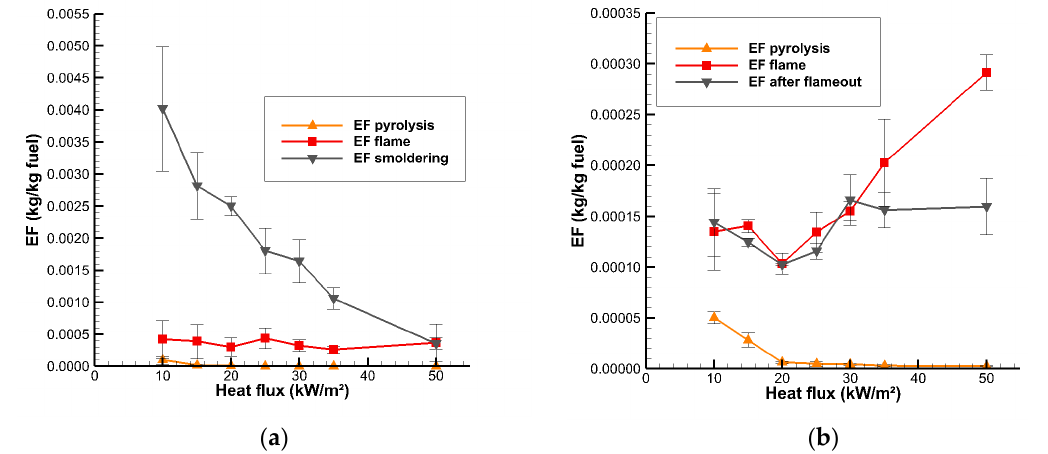
Figure 14. EF for CH 4 for an imposed heat fl ux ranging from 10 to 50 kW/m 2 for ( a ) wood and ( b ) thermoplastic samples.